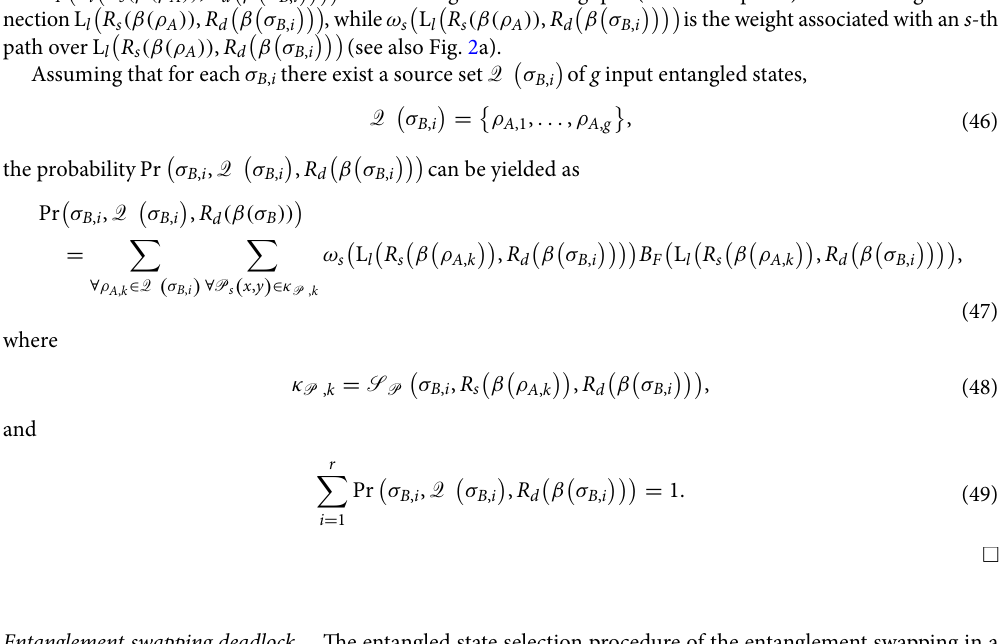
Entanglement swapping deadlock. The entangled state selection procedure of the entanglement swapping in a quantum repeater R i can lead to a deadlock in the establishment of an entangled connection L l ( R i , R d )